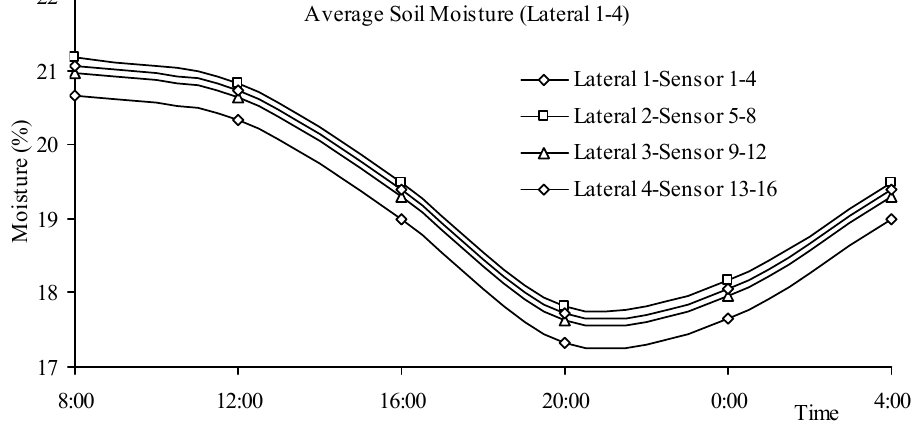
Figure 11. The average moisture values are occurring in the sensor during the day (Mid. Stage).